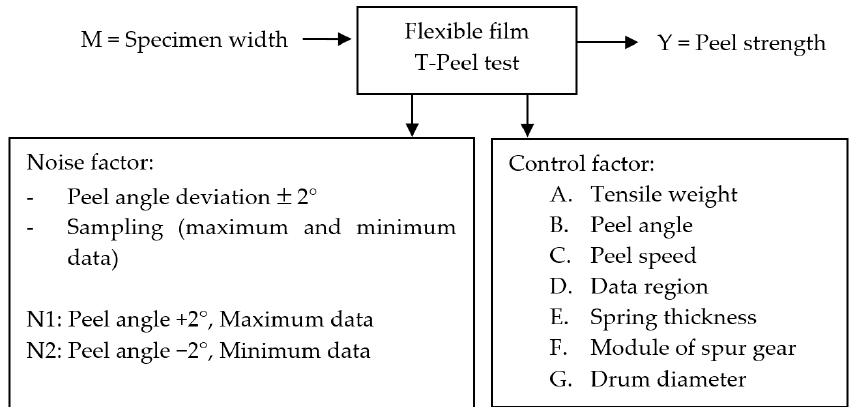
Figure 5. P-diagram for flexible film.